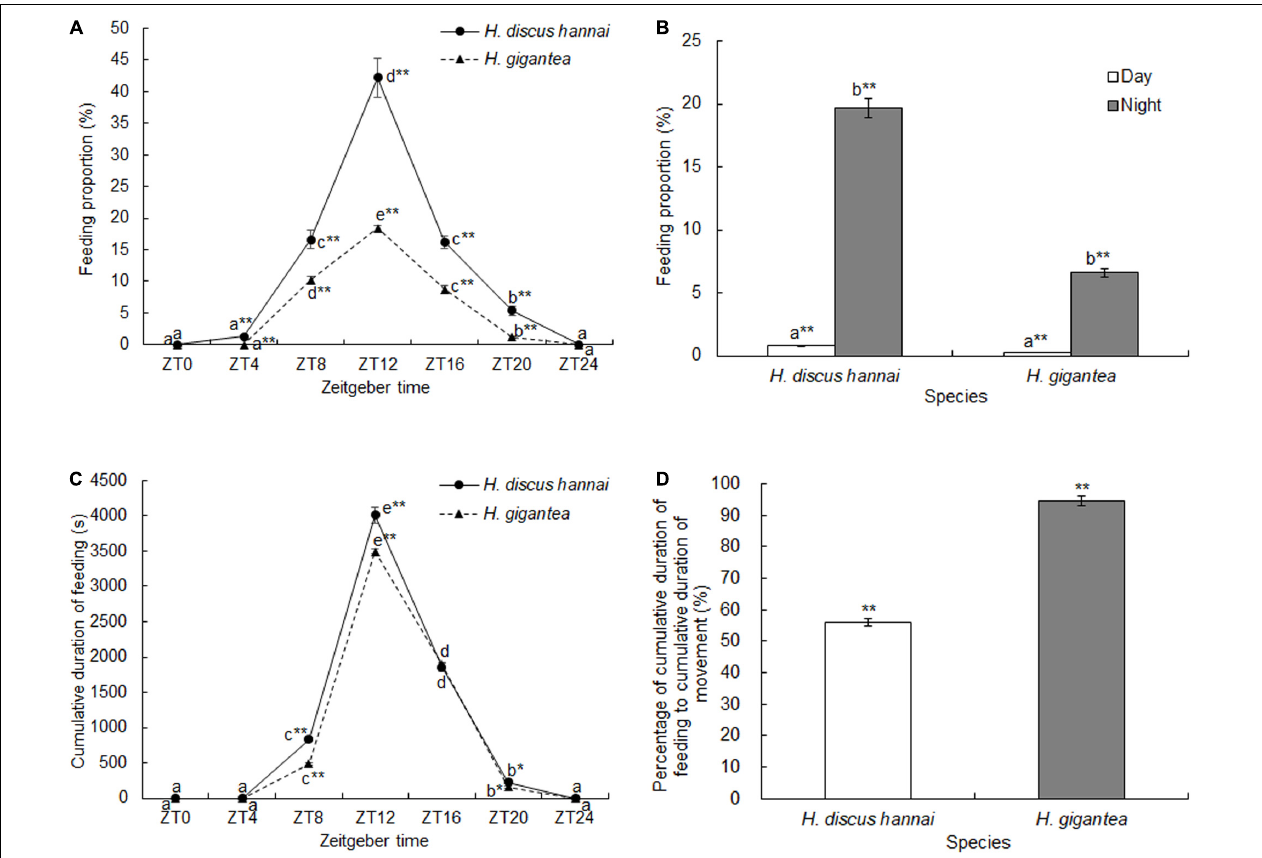
FIGURE 2 | Proportion of time spent feeding (A,B) , cumulative duration of feeding (C) , and percentage of cumulative duration of feeding relative to cumulative duration of movement (D) in Haliotis discus hannai and Haliotis gigantea . Values are expressed as mean ± SE, sample size = 30. Treatments with different letters are significantly different at different sampling times in the same species ( P < 0.05). “*” and “**” indicate significant differences ( P < 0.05 and P < 0.01, respectively) in the feeding parameters at the same sampling time in different species. No label indicates no significant difference ( P < 0.05) in the feeding parameters at the same sampling time in the same